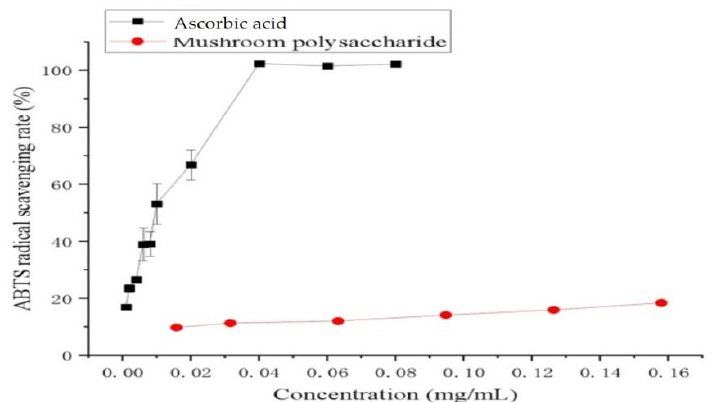
Figure 5. In vitro antioxidant activity assessment of ABTS radical scavenging activity of polysaccha- ride from chestnut mushroom. Values are expressed as mean ± SD ( n = 3).